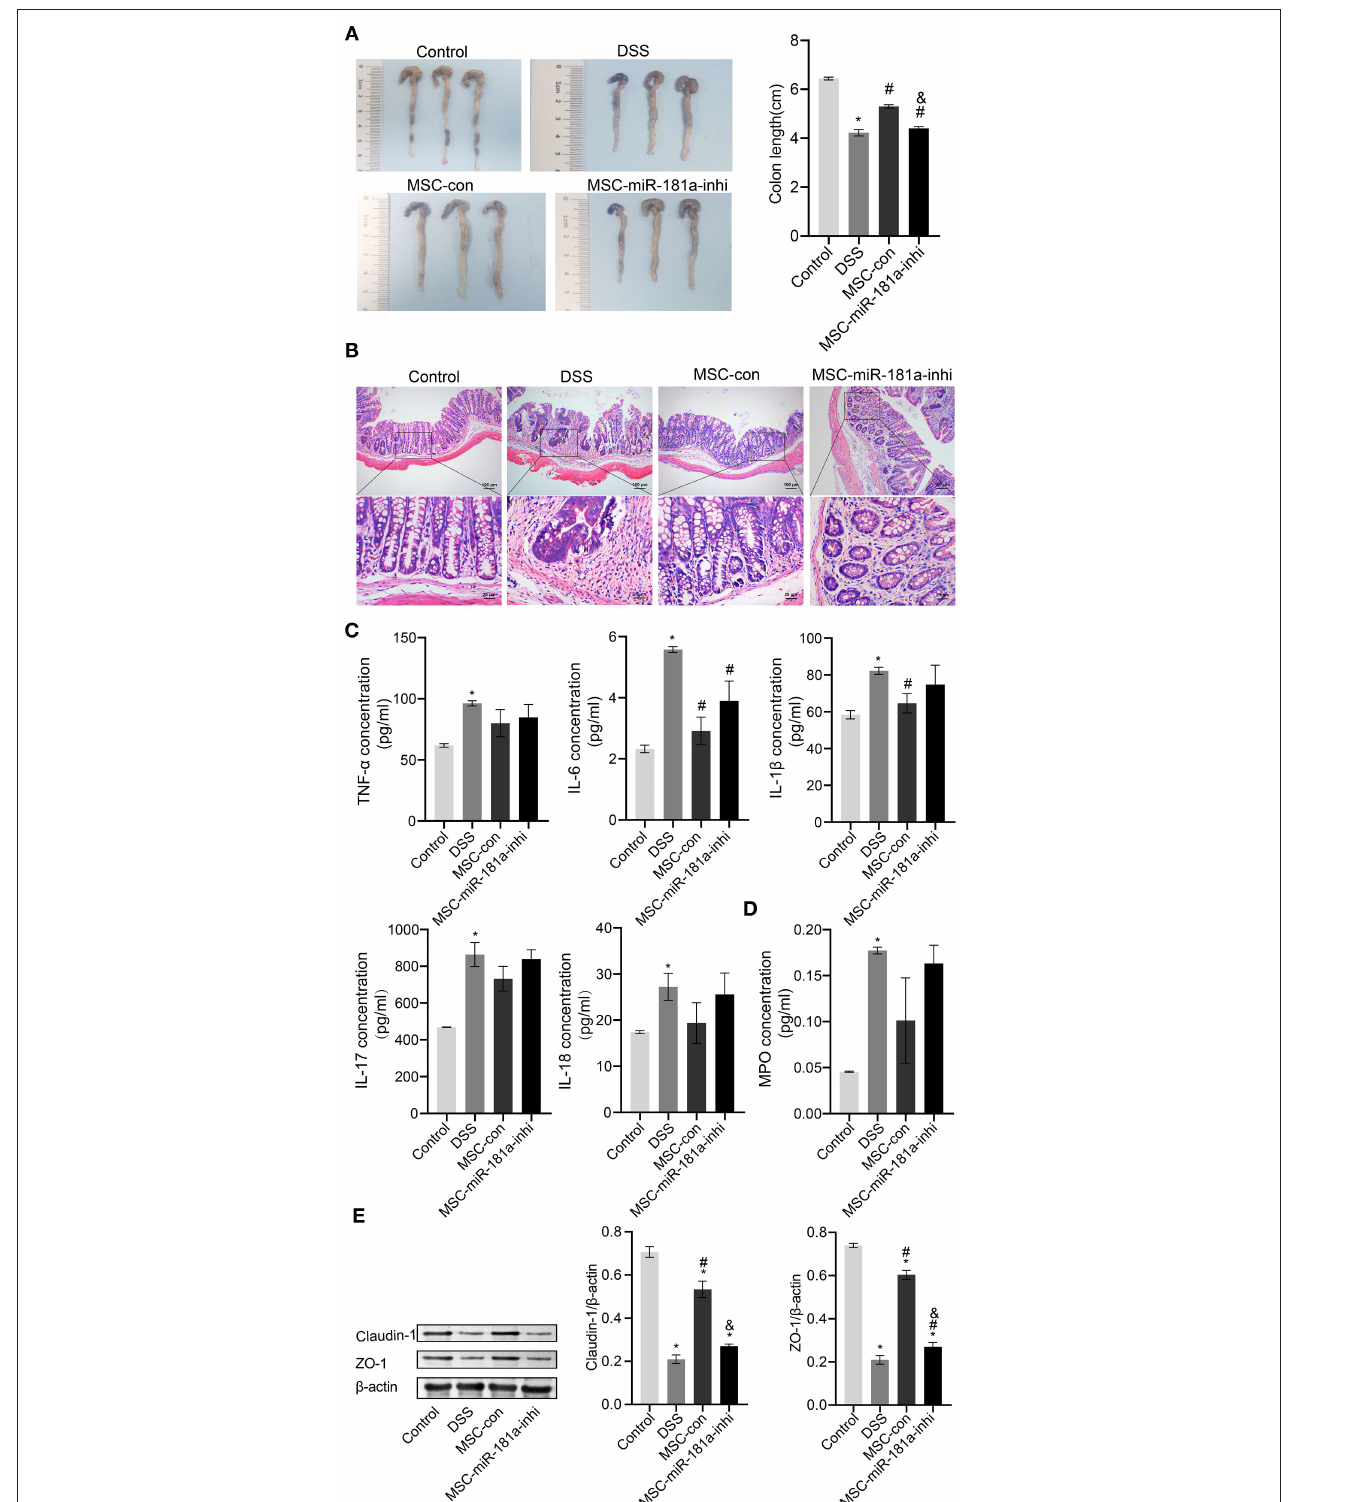
FIGURE 5 | Exosomal miR-181a attenuated DSS-induced injury in vivo . (A) The appearance and length of the colon in mice were analyzed. (B) H&E staining of colonic pathological features in the mice. Scale bar: 100 or 25 µ m. (C) The concentrations of TNF- α , IL-6, IL-1 β , IL-17, and IL-18 in serum were measured via ELISA. (D) MPO activity in colon tissue was measured via ELISA. (E) Western blotting was used to detect the expression of the tight junction proteins Claudin-1 and ZO-1. * P < 0.05 vs. the control. # P < 0.05 vs. the DSS group. & P < 0.05 vs. the MSC-con group. n = 10 mice/group. DSS, dextran sodium sulfate; MPO, myeloperoxidase.